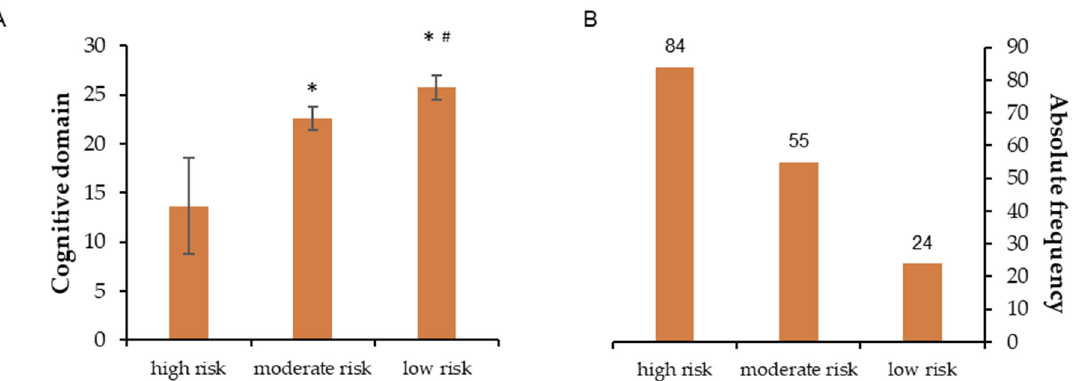
Figure 1. ( A ): Mean ± standard deviation for each risk group of the cognitive domain. * p < 0.001 compared to high risk; #: p = 0.002 compared to moderate risk. ( B ): Absolute frequency of older adults in each risk group .